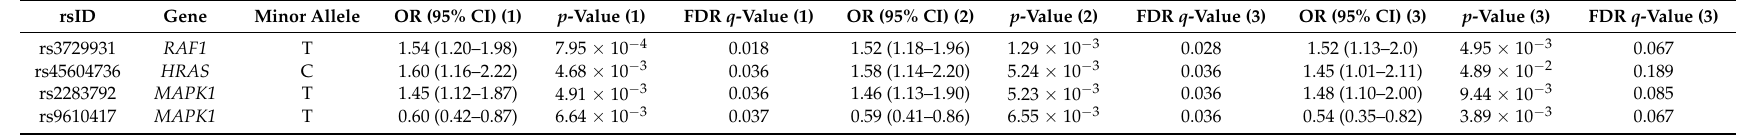
Table 2. Single nucleotide polymorphisms (SNPs) associated with gastric cancer with the smallest p -value for allele